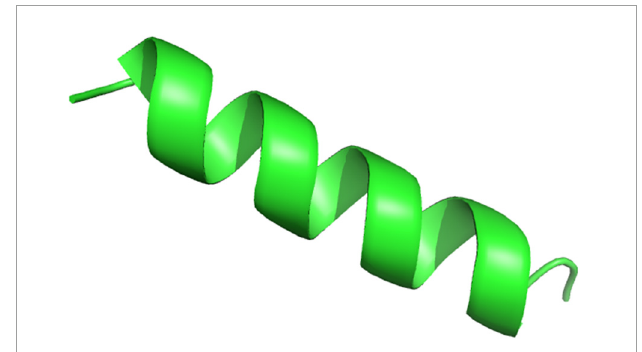
FIGURE1 Prediction result of the spatial structure of HJH-3. Copy and paste the sequence of VNFKLLSHSLLVTLRSHL into the Specified location of the website (https://zhanglab.ccmb.med.umich.edu/I-TASSER/). Run the I-TASSER with default